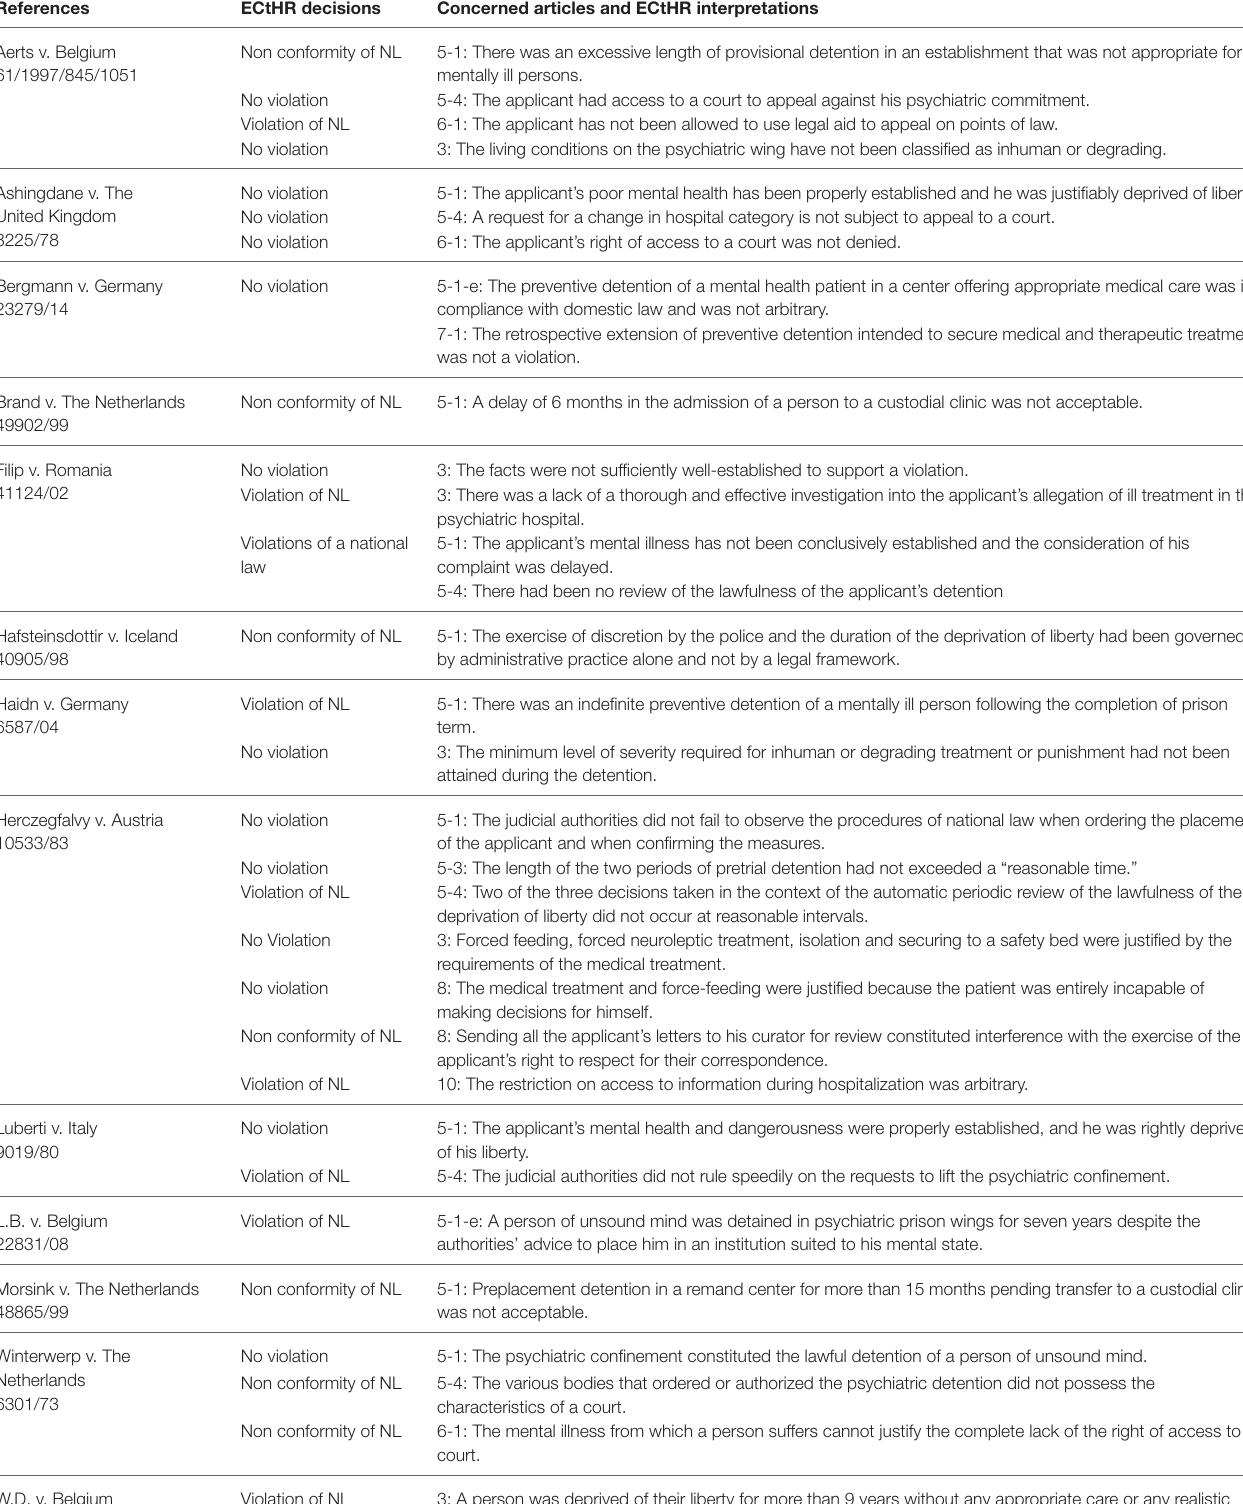
TABLE 3 | ECtHR level 1 case law concerning psychiatric